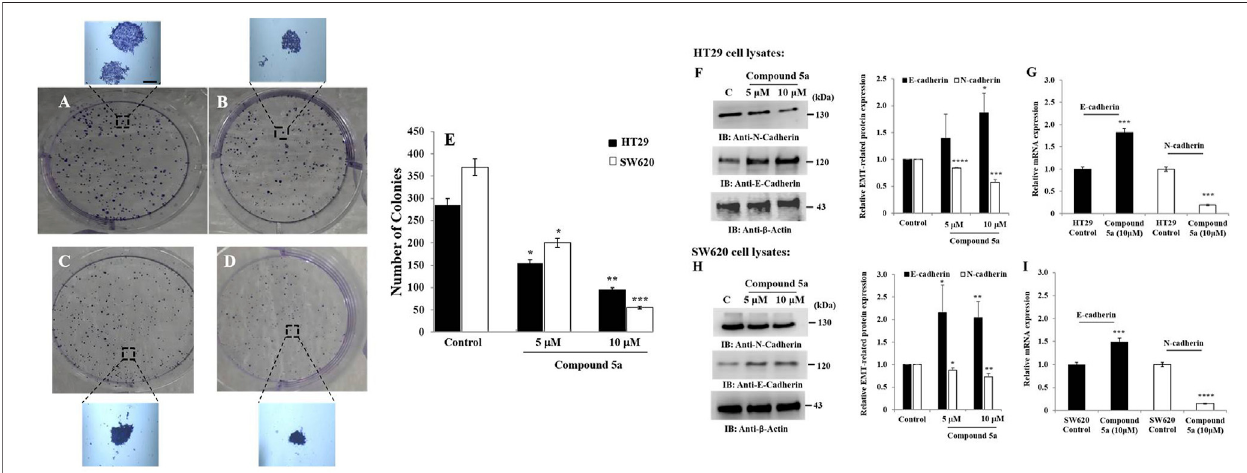
FIGURE 3 | Compound 5a inhibits colony formation of HT29 and SW620 cells and upregulates E-cadherin and N-cadherin expression in both cell lines. Both HT29 (B) and SW620 (D) cells were further incubated for 10 – 12 days for colony formation at 37 ° C, along with untreated HT29 (A) and SW620 (C) cells. Crystal violet staining was done, and the number of colonies was determined using a light microscope. (E) The bar graph depicts the number of colonies, and the data are shown as mean ± SD ( n = 3). Total HT29 (F) and SW620 (H) cell lysates were immunoblotted against the indicated antibodies (i.e., N-cadherin and E-cadherin). Bar graph indicating therelativeprotein expression level related tothe loading control ß -actin. Bar graph showing the relative mRNA expression level of E-cadherin and N-cadherin relatedtotheinternal controlGAPDHmonitoredinHT29 (G) and SW620 (I) RNAextracts. Dataareshown asmean±SD( n =3). * p < 0.05, ** p < 0.01, *** p < 0.001,and **** p < 0.0001 vs . Control.